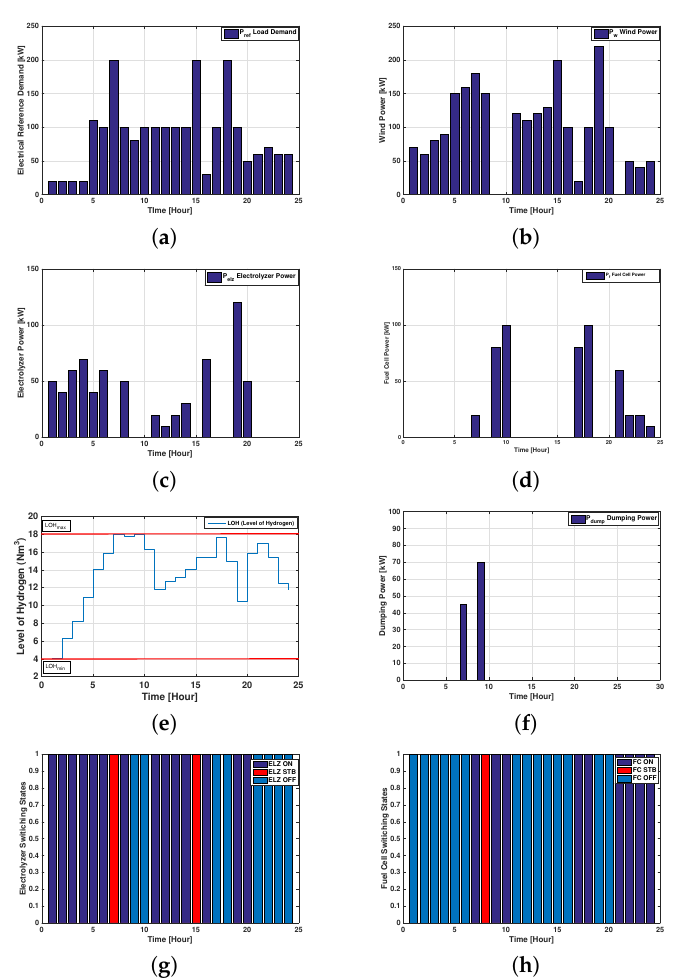
Figure 4. Numerical results for Example 1. ( a ) Electrical Reference Demand. ( b ) Forecasted Wind Power. ( c ) Power of the Electrolyzer. ( d ) Power of the Fuel Cell. ( e ) Level of Hydrogen. ( f ) Dump Load. ( g ) Electrolyzer Switching States. ( h ) Fuel cell Switching